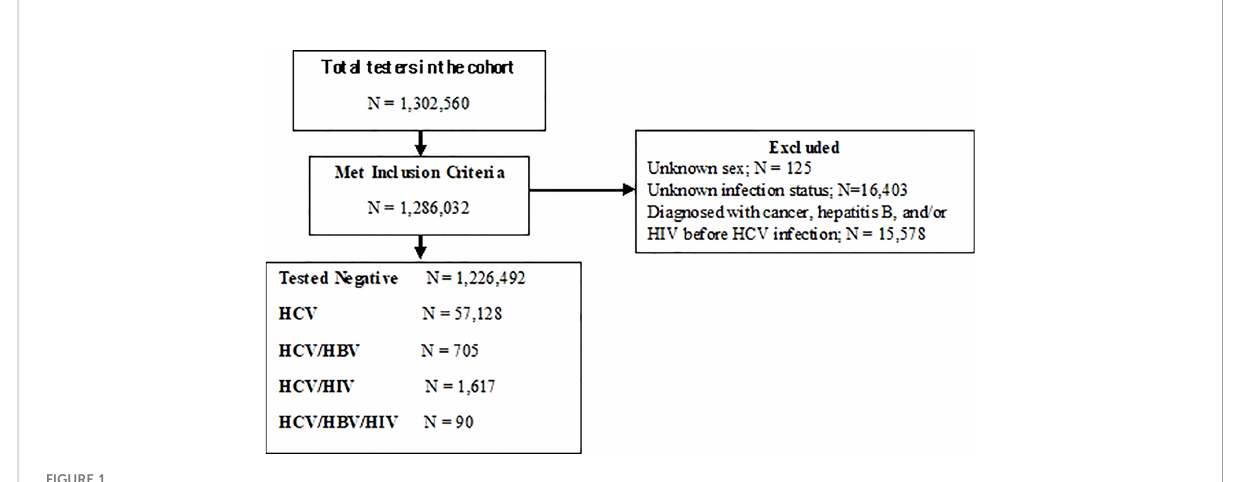
FIGURE 1 Study Flow